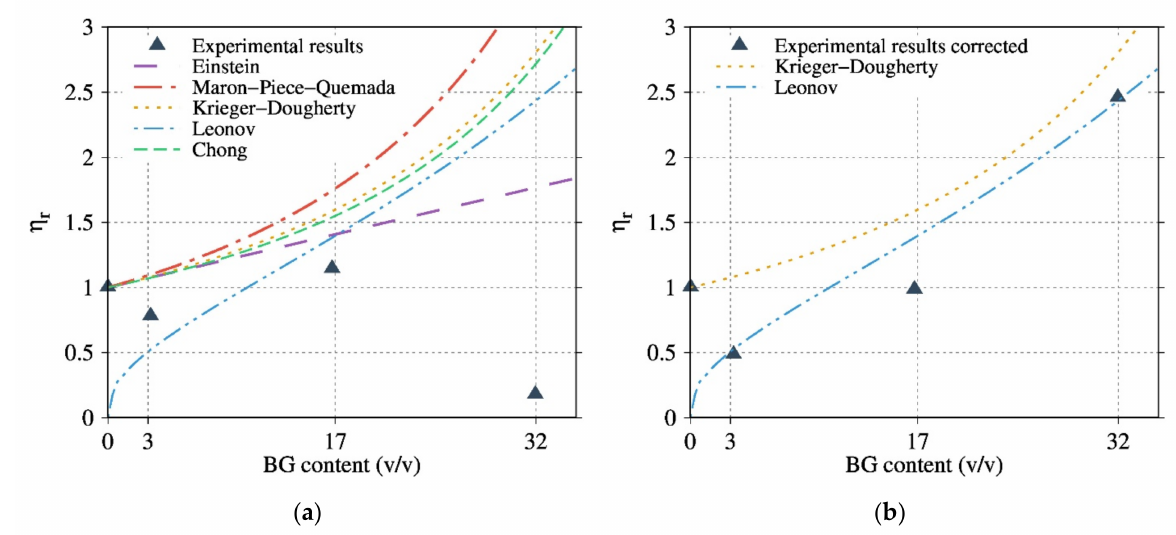
Figure 9. Relative viscosities or hydrodynamic interaction versus the BG volume percentage for composites of PDLA filled with BG 0.04–0.5 mm T3. Comparison between ( a ) the measured experimental values of the relative viscosities and the Einstein, Maron-Piece-Quemada, Krieger-Dougherty, Leonov and Chong et al. models and ( b ) the corrected relative viscosities calculated from the real M w (Equations (10) and (11)) values compared with the theoretical relative viscosities calculated from the Leonov and Krieger-Dougherty Leonov